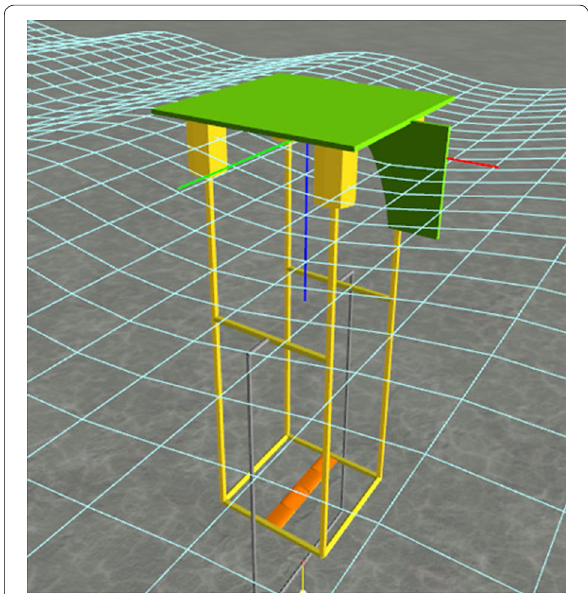
Fig. 8 Simulated model in the PDS environment. A typical buoy with a fixed rudder attached to the four floaters at corners and the submerged stabilization system is shown